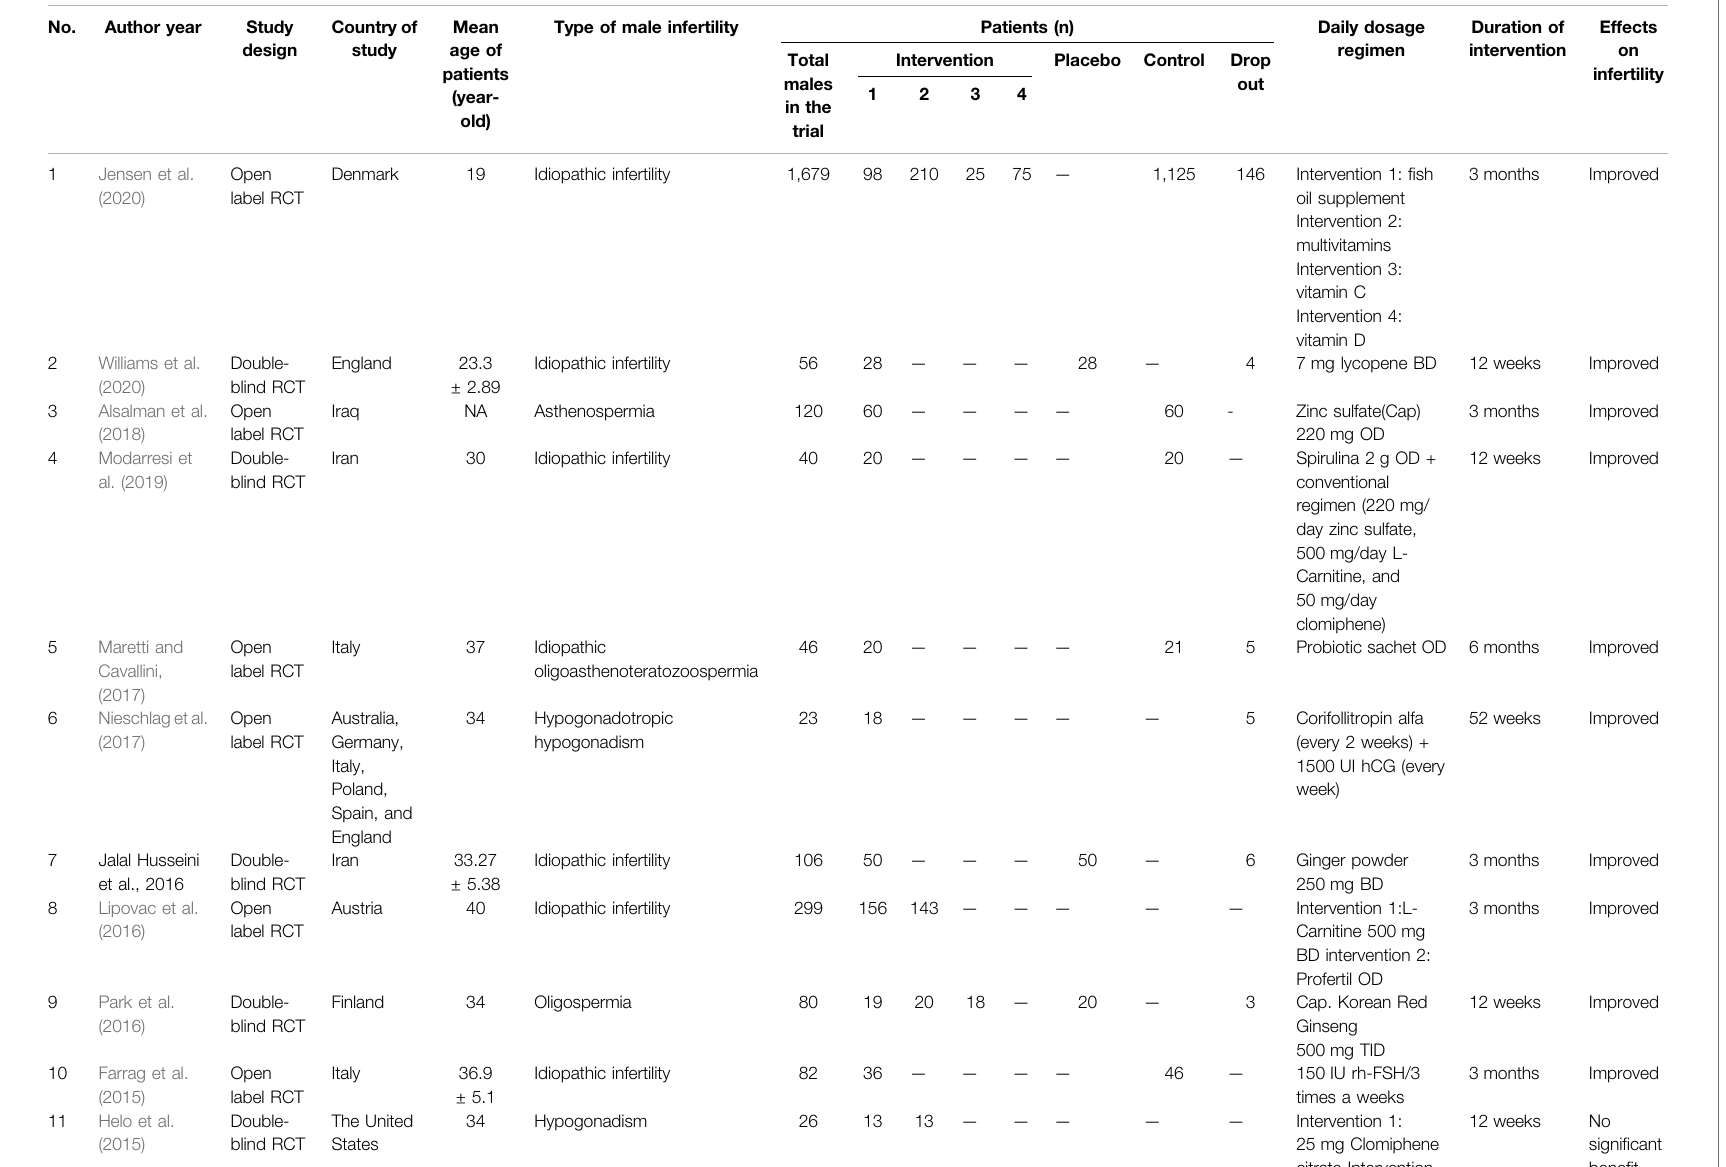
TABLE 2 | Characteristics of studies treating male patients with infertility (n (cid:1) 80).